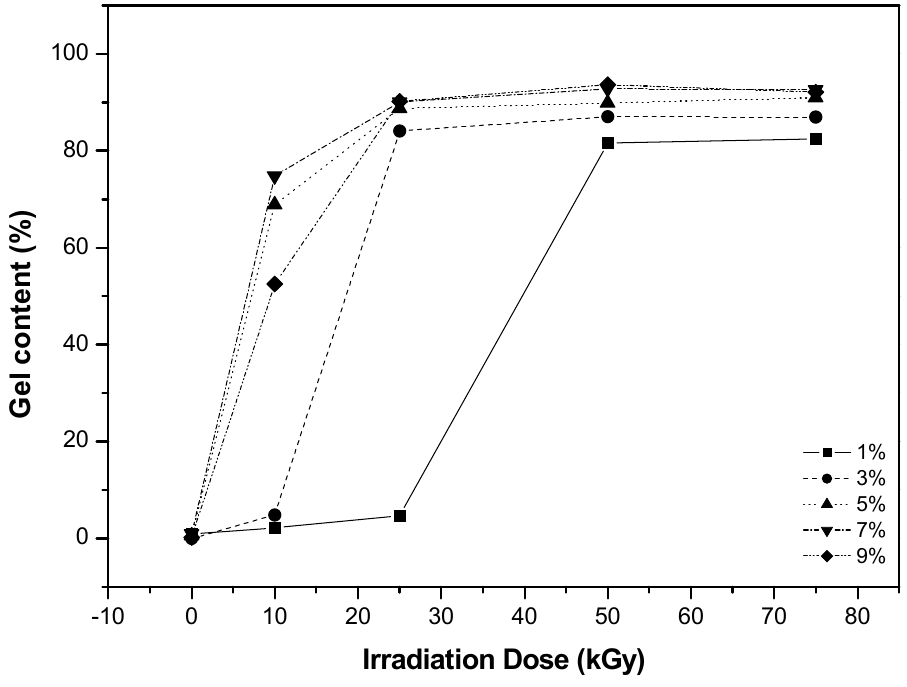
Figure 2. The effect of irradiation dose on the gel content in various concentration of poly(acrylic acid).